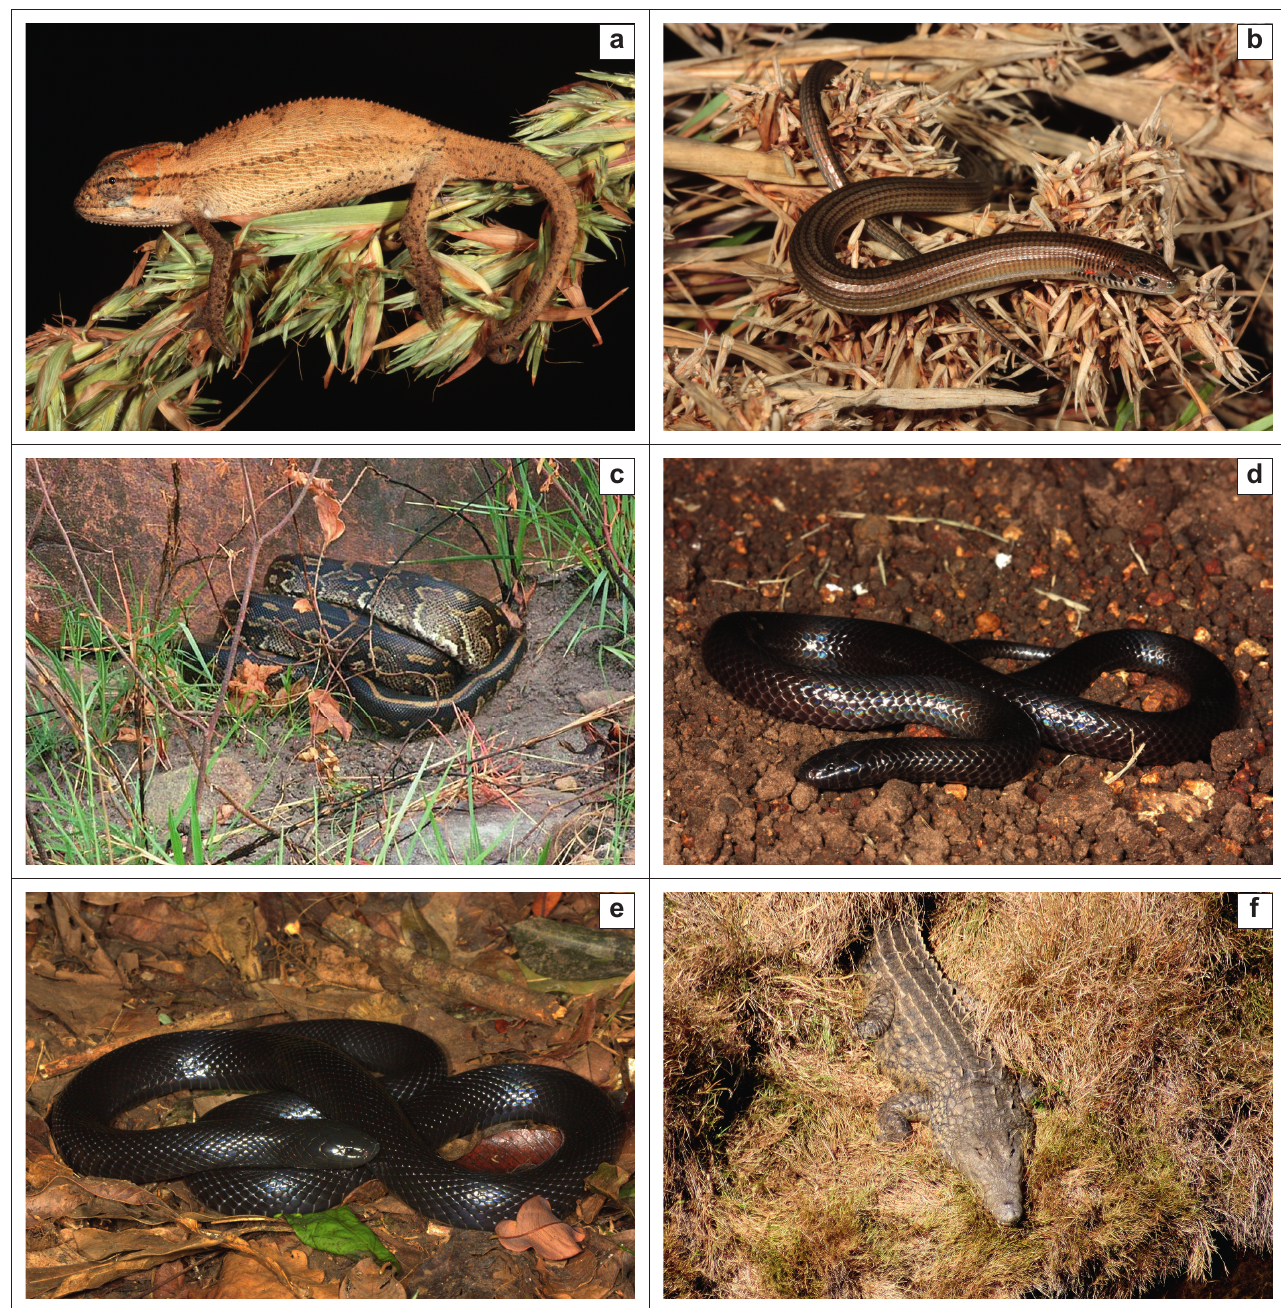
FIGURE 4: Reptile species of special or conservation concern recorded in protected areas along the Wild Coast, including (a) Bradypodion caffer (Mkambati NR), (b) Tetradactylus cf. fitzsimonsi (Hluleka NR), (c) Python natalensis (Mkambati NR), (d) Amblyodipsas concolor (Hluleka NR), (e) Macrelaps microlepidotus (Manubi SF) and (f) Crocodylus niloticus (Dwesa